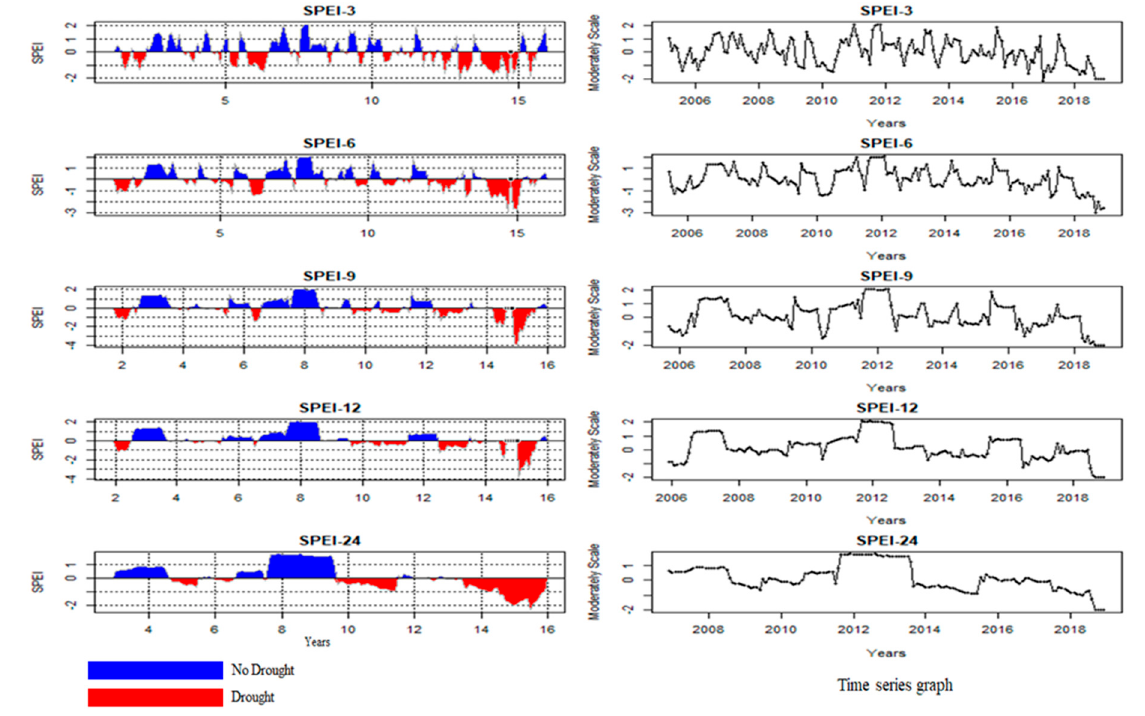
Figure 3. Time series plots of SPEI- 3, 6, 9, 12 and 24 are in right panel, and the left panel shows drought condition plots of SPEI- 3, 6, 9, 12 and 24.